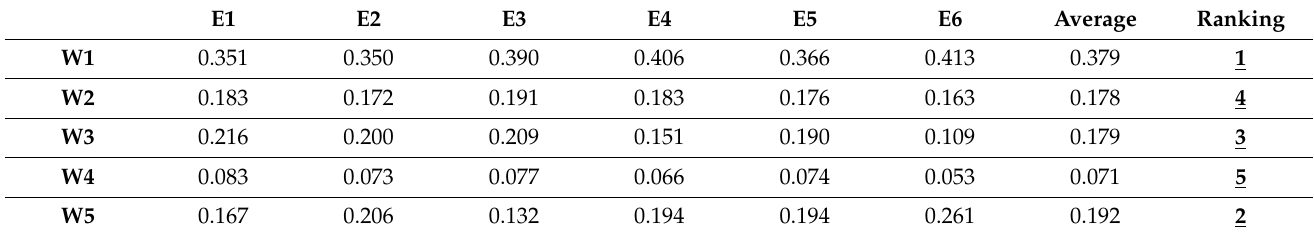
Figure 9. Weighted criteria expressed as percentages, according to Expert 6. Table 9. Final ranked list of decision variants based on expert scoring.